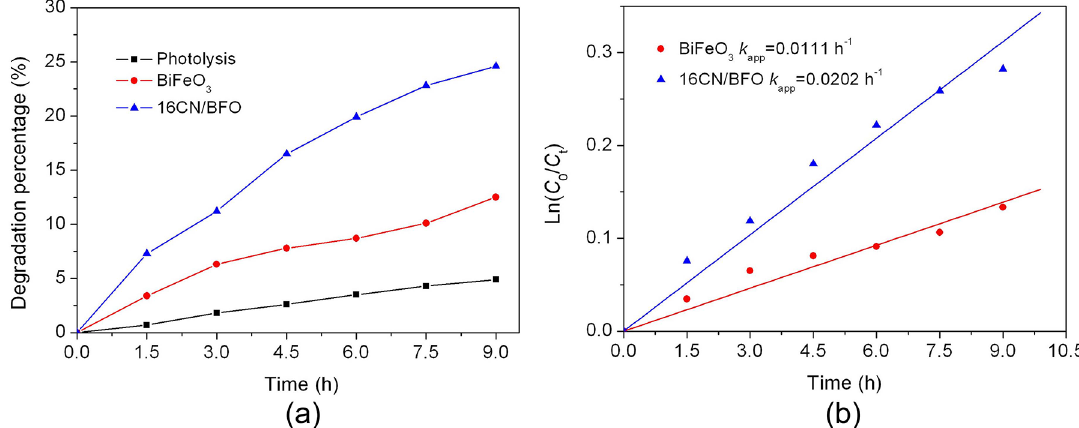
and 16CN/BFO sample, along with blank experiment. 3 and 16CN/BFO sample. Initial conditions: C (phenol) = 5 mg/L, 3